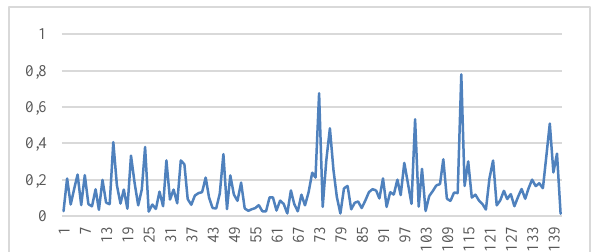
Figure 16 –Distribution of average standard deviation expressed in gons for all the 141 oriented churches.